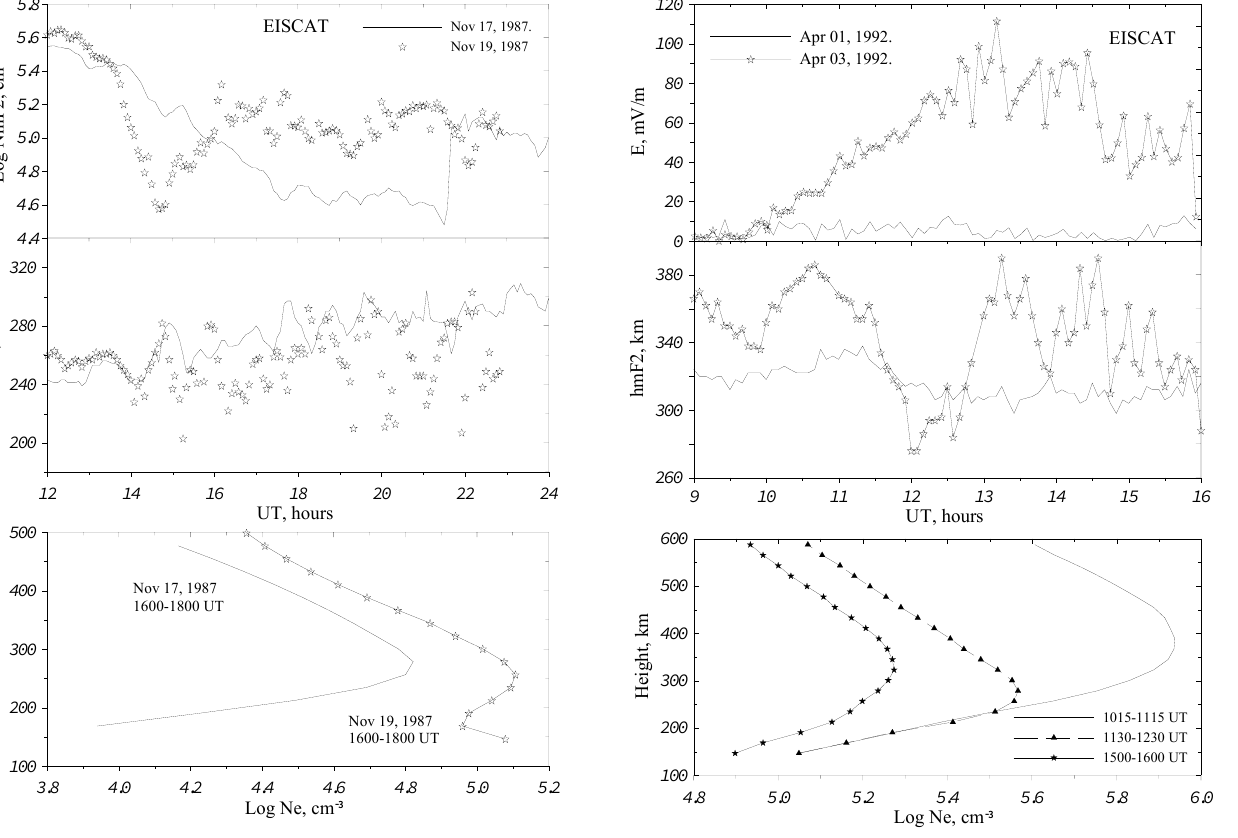
Fig. 9. Fig. 9. The effect of a strong electric field (top panel) resulting in a large hm F2 decrease at the initial phase of the storm observed with EISCAT on 3 April 1992. A quiet reference day, 1 April 1992, is given for a comparison. The hm F2 decrease results from a strong decrease in the electron concentration above 240km due to a hori- zontal plasma transfer under the E × B